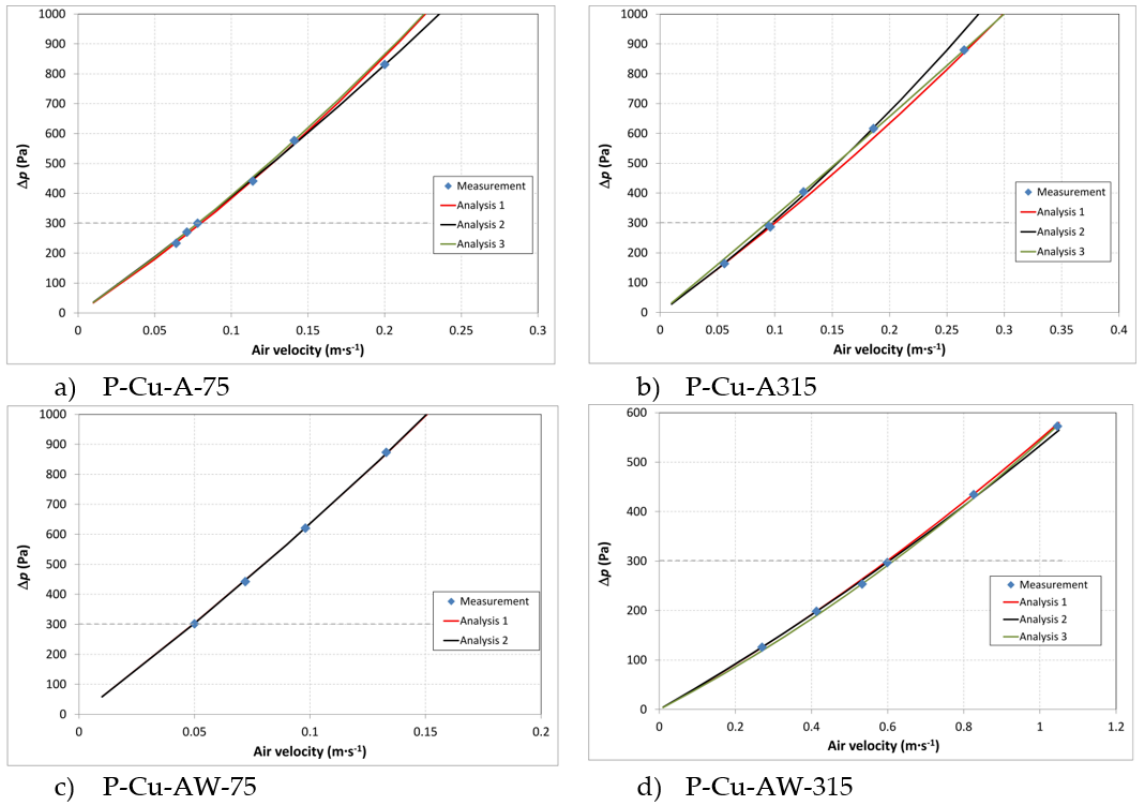
Figure 7. Correlation between the pressure losses and the velocity of the air flow.